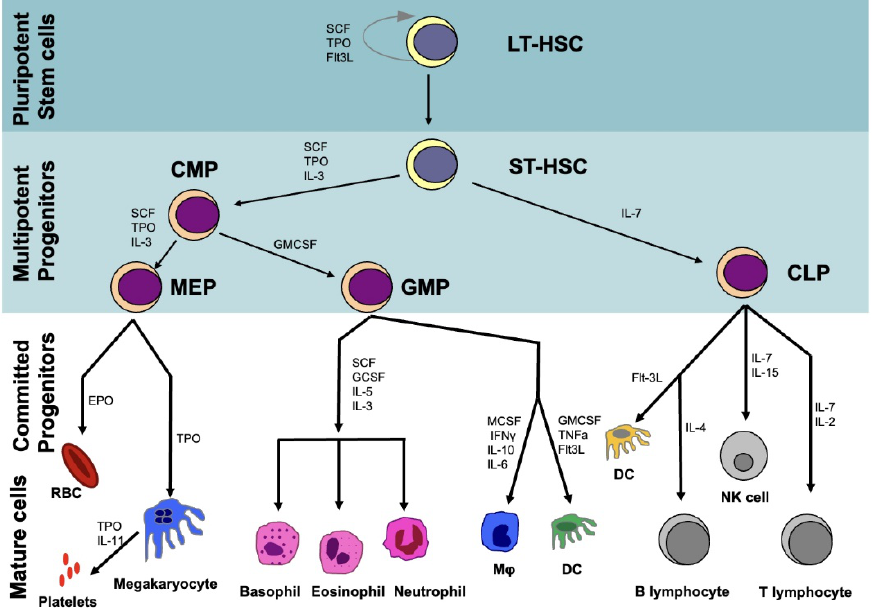
Figure 1. Outline of the hierarchy in the hematopoietic system. HSCs reside at the apex of the hematopoietic system and through a dynamically regulated process self-renew or differentiate to gradually give rise to multipotent progenitors (CMPs, CLPs). These in turn produce GMPs and MEPs and differentiate into committed progenitors and mature blood cells. LT-HSCs = long-term HSCs, ST-HSCs = short-term HSCs, CMPs = common myeloid progenitors, CLPs = common lymphoid progenitors, GMPs = granulocyte-macrophage progenitors, MEPs = megakaryocyte-erythrocyte progenitors, DC = Dendritic cells, M ϕ = Macrophage, SCF = Stem cell factor, TPO = Thrombopoietin, Flt3L = Flt3 Ligand, IL = Interleukin, GMCSF = Granulocyte macrophage colony stimulating factor, MCSF = macrophage colony-stimulating factor.